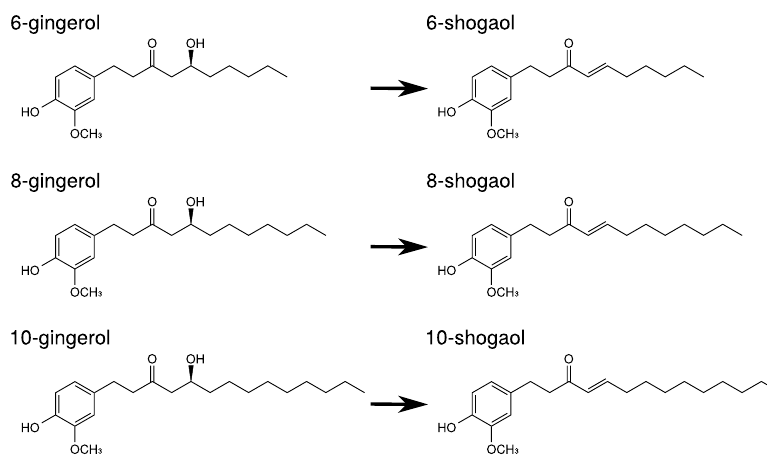
Figure 5. The structures of ingredients in shokyo ( Zingiberis Rhizoma ) and kankyo ( Zingiberis Processum Rhizoma